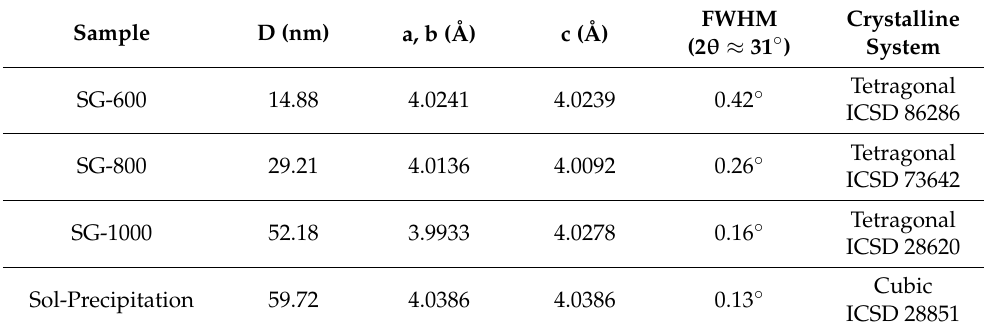
Table 1. Average size of crystallites obtained by the Scherrer equation and tetragonality index of the powders obtained by the sol-gel method and heat-treated at different temperatures (600 ◦ C, 800 ◦ C and 1000 ◦ C) and by the sol-precipitation